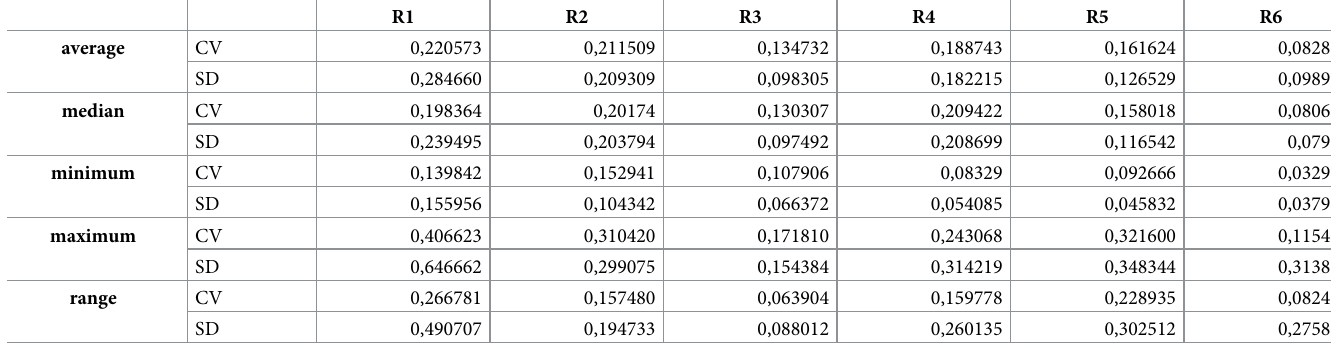
Table 1. Comparison of selected moment characteristics of criteria weights (CV vs.